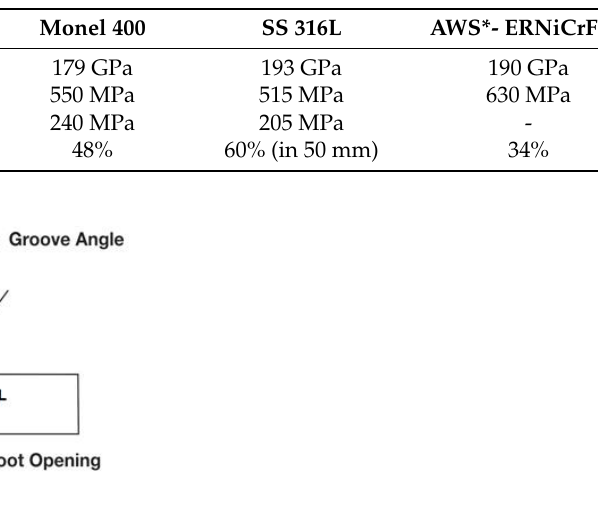
Figure 1. Weld groove typical section. Table 3. Welding parameters.